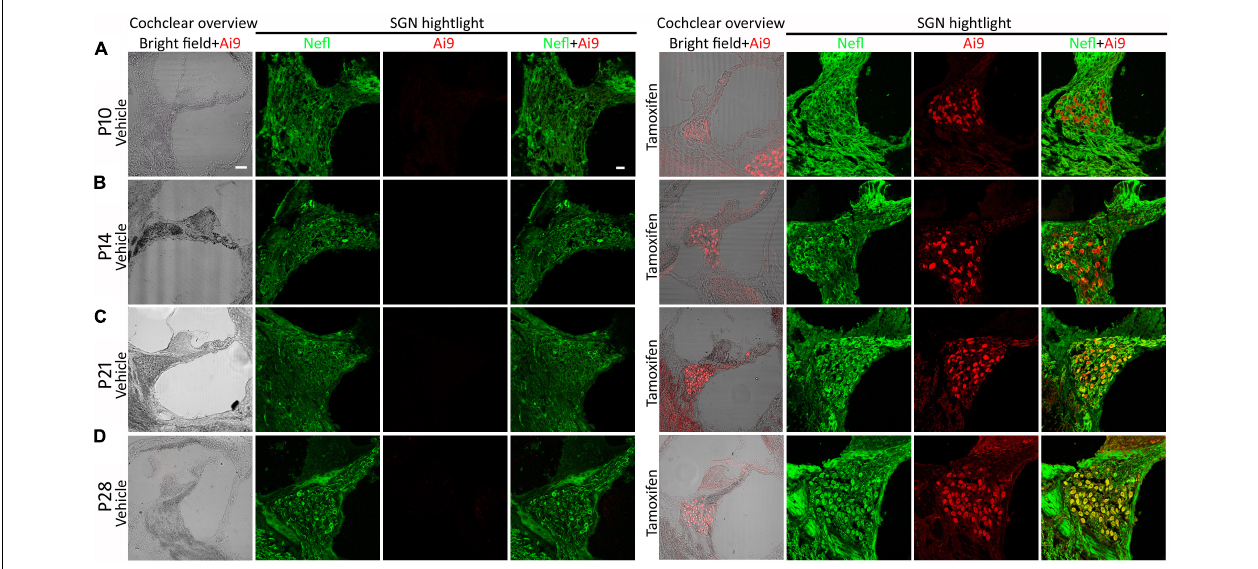
FIGURE 2 | Cre activity of Nefl CreER / + mice. Nefl CreER / CreER mice were crossed with a reporter strain, Ai9, to obtain heterozygous Nefl CreER / + ;Ai9 + / − mice, which were treated with tamoxifen or vehicle on postnatal day 1 (P1) for 4–5 consecutive days. The pups were euthanized on P10 (A) , P14 (B) , P21 (C) , and P28 (D) . In the vehicle group, no significant Ai9 tdTomato fluorescence was observed in the cochlear overview or spiral ganglion neuron (SGN) area highlight. However, robust Ai9 tdTomato fluorescence was identified in the cochlear overview and SGN area highlight in heterozygote mice treated with tamoxifen. In the SGN area, Ai9 tdTomato fluorescence was co-labeled with Nefl immunofluorescence in the tamoxifen groups, whereas only Nefl immunofluorescence was observed in the vehicle groups (A–D) , suggesting tamoxifen-induced Cre activity of Nefl CreER / + ;Ai9 + / − mouse SGNs. Scale , 50 µ m in cochlear overview and 20 µ m in SGN highlight.